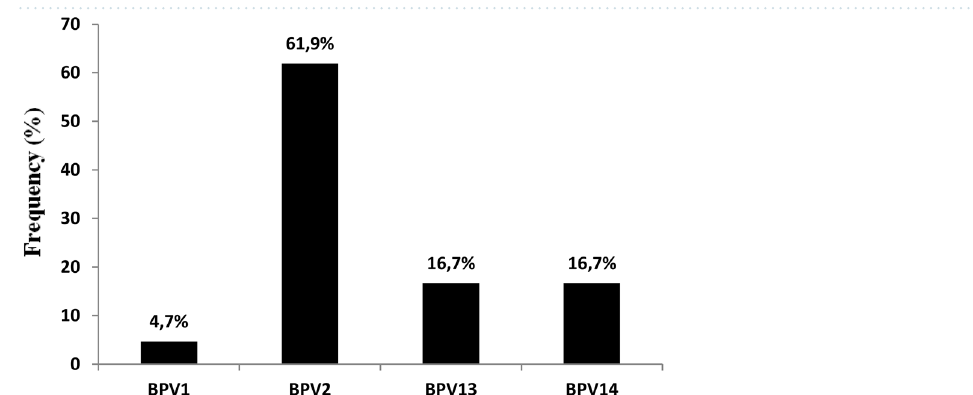
one negative sample and for BPV14 two positive and one negative samples are shown, respectively.